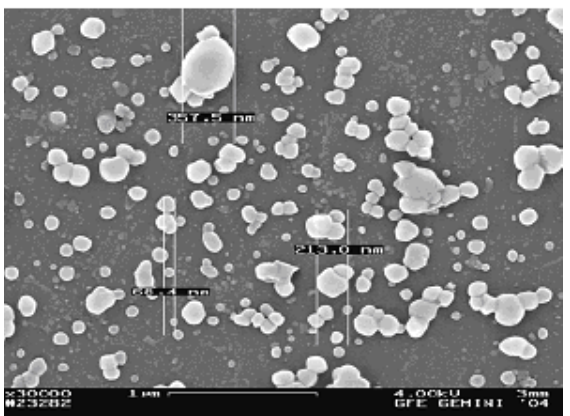
Figure 5 – Cobalt powders obtained at 800 °C, C =0.04 mol/l by USP Рис . 5 – Кобальтовые порошки , полученные при 800 ° С , с = 0,04 моль / л , ультразвуковым распылением раствора Слика 5 – Прахови кобалта добијени на 800°C, c=0,04 mol/l, ултразвучним распршивањем